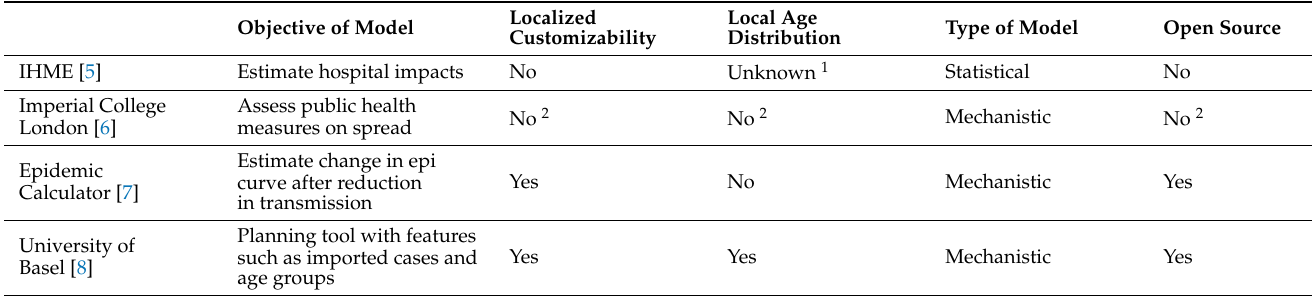
Table 1. Landscape of selected models for informing COVID-19 control and mitigation,